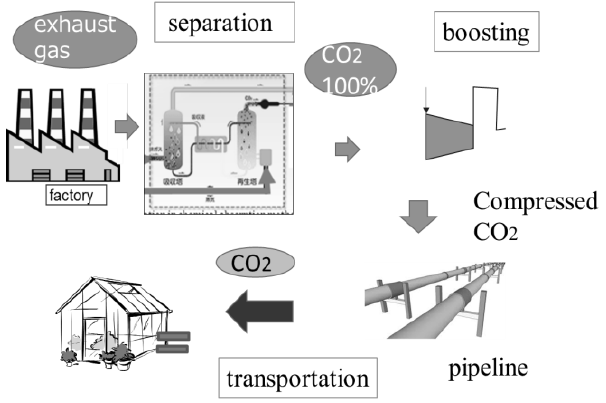
Figure 3. Transportation by pipeline type.